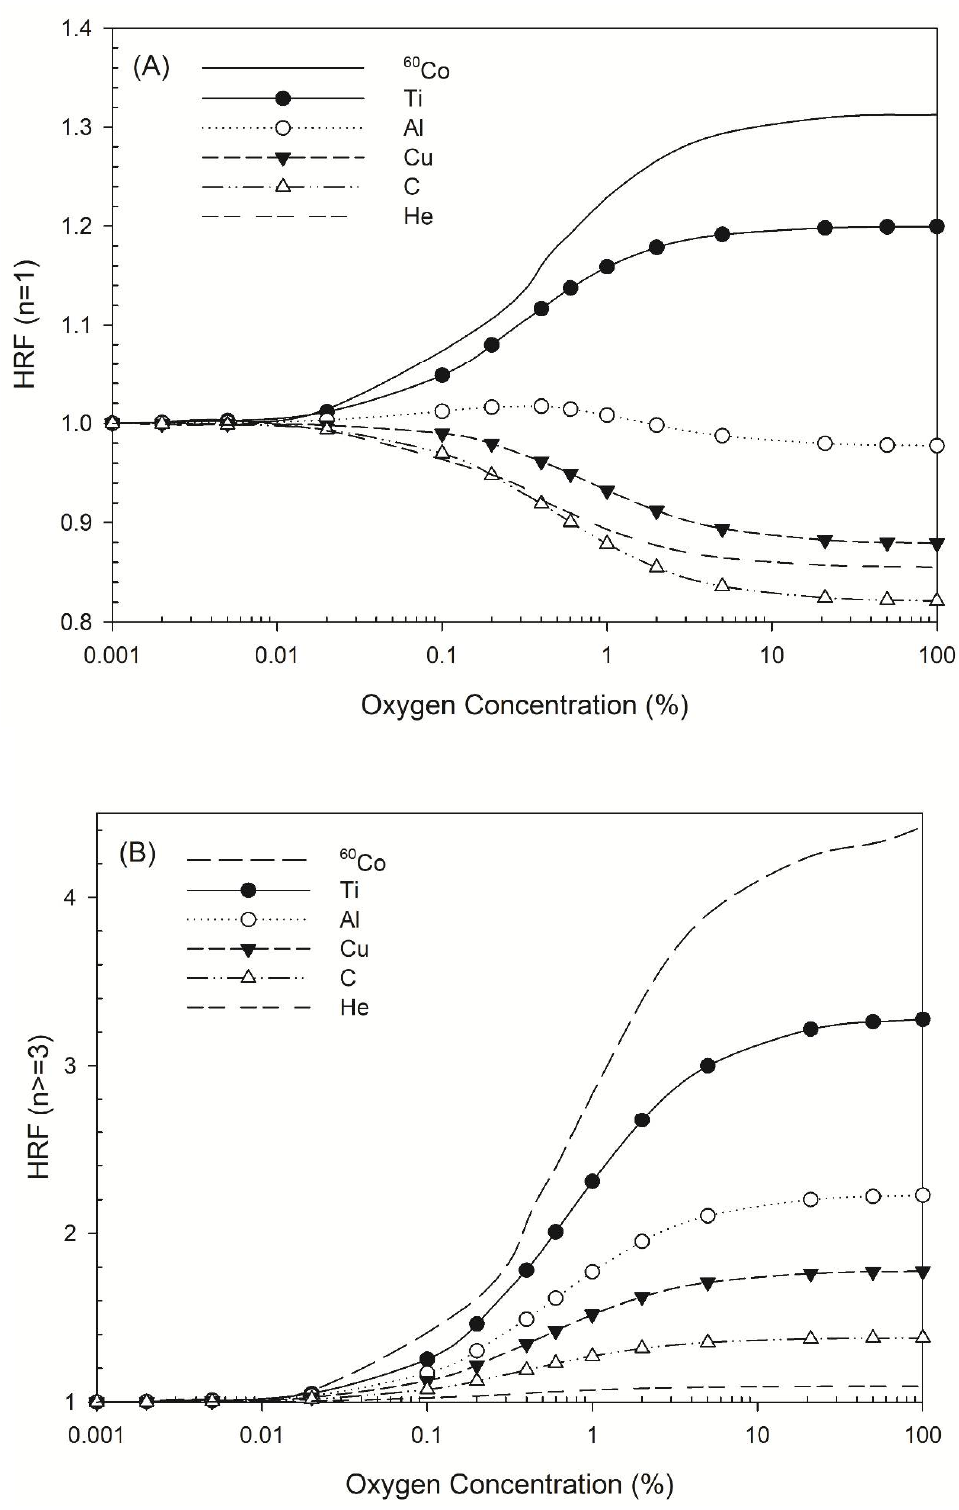
Figure 2. HRF for different types of radiation at various oxygen concentrations. The symbols Ti, Al, Cu, C, and He represent titanium K-shell, aluminum K-shell, copper L-shell, and carbon K-shell X-rays, and helium ions. ( A ) HRF for DNA damage with n = 1 lesion as a function of oxygen concentration and ( B ) HRF for DNA damage with n ≥ 3 lesions as a function of oxygen